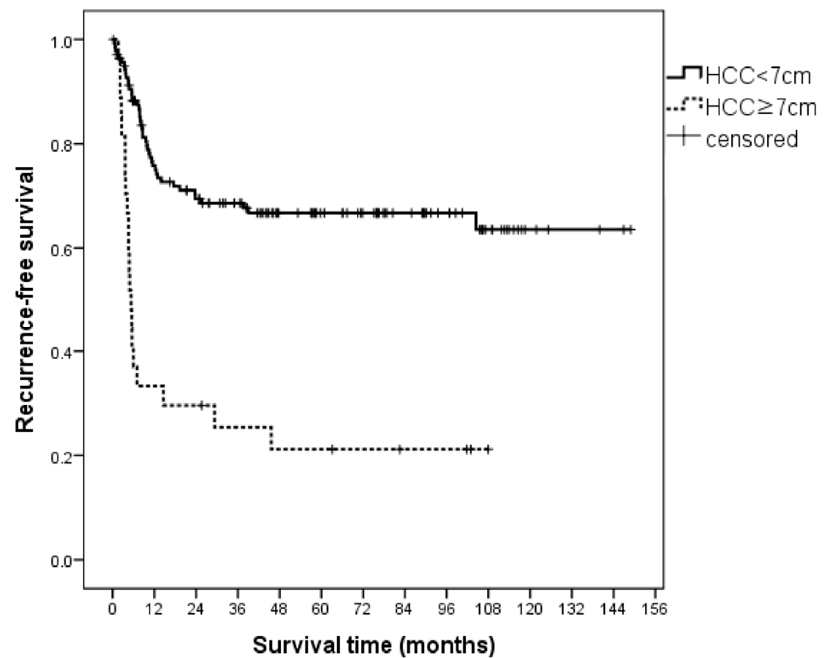
Figure 4. Comparisons of RFS in BM patients according to maximum tumor size (=7 cm). The 1-, 3-, and 5-year RFS of patients with HCC < 7 cm and HCC ≥ 7 cm were 75.8%, 69.6%, and 66.7%, and 33.3%, 25.4%, and 21.2% ( p < 0.05). These patients showed a median survival time of 5.3 months (95% CI, 4.1–6.4) and 21 patients had HCC recurrence, BM, beyond the Milan criteria; HCC, hepatocellular carcinoma; RFS, recurrence-free survival.